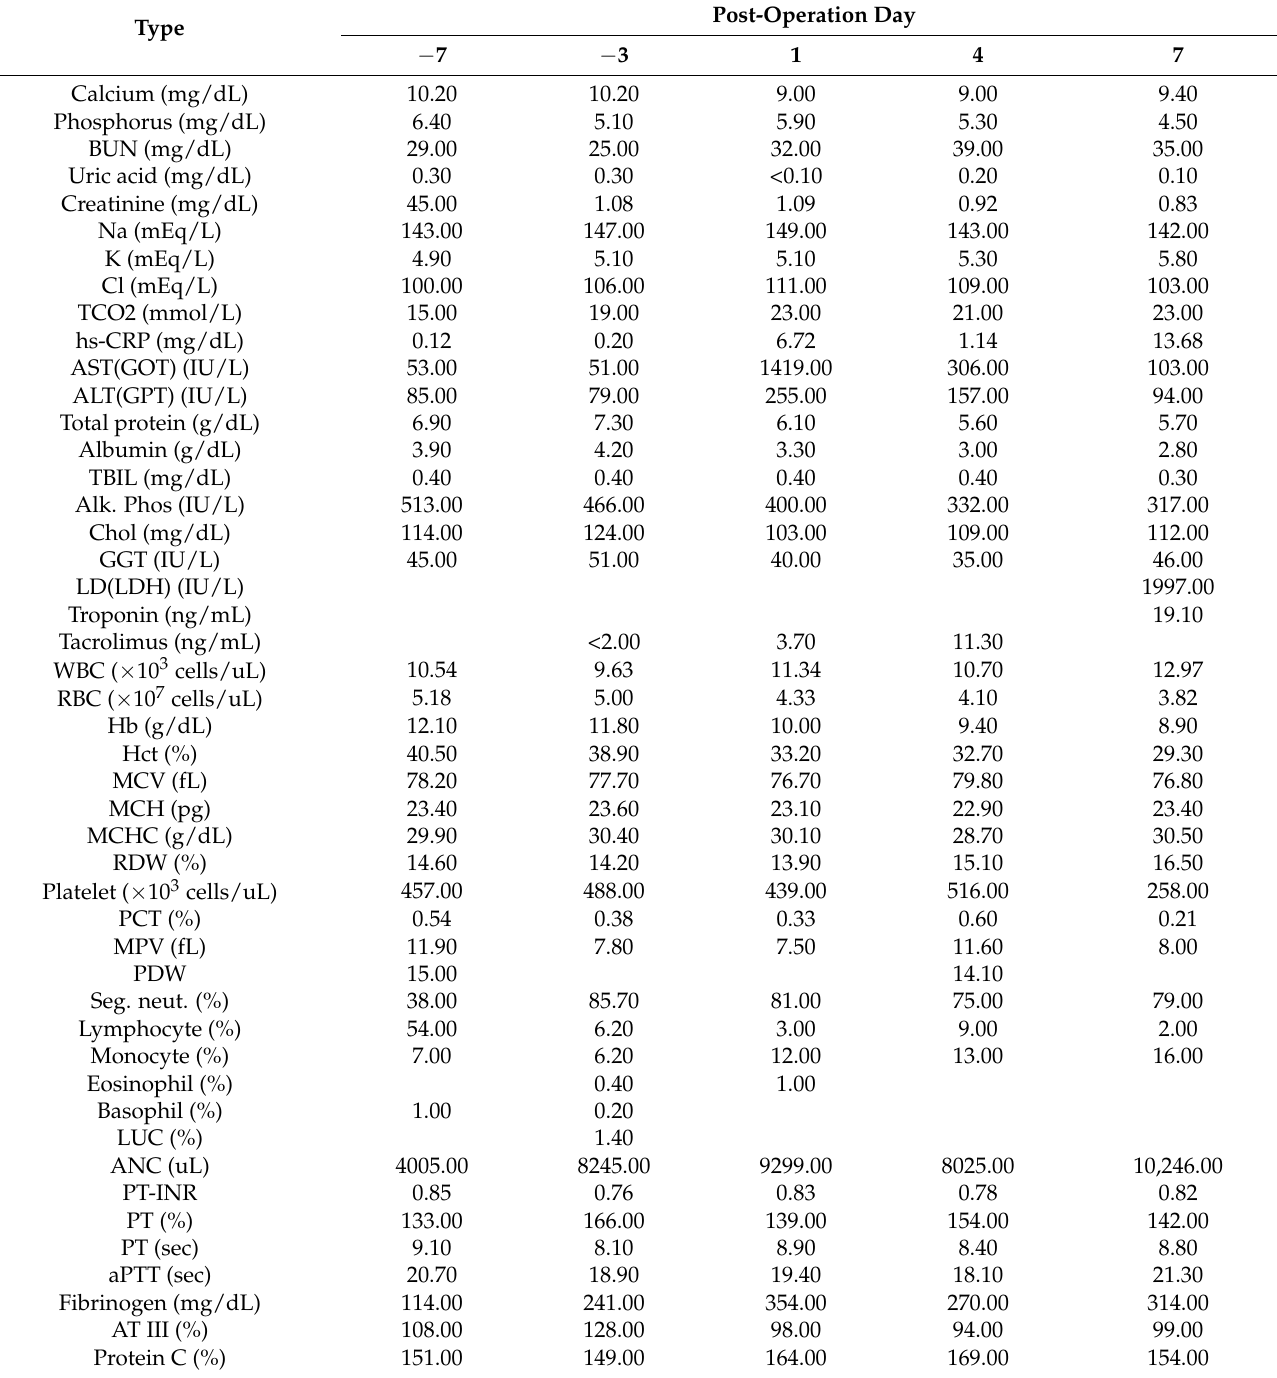
Table 1. Hematological and biochemical blood parameters of recipient cynomolgus